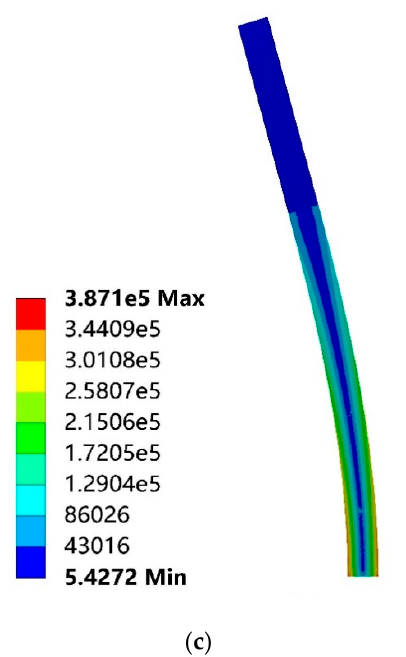
Figure 14. Stress (Pa) of T-shaped flexible beam at t = 10 s ( a ) Re = 25,500, ( b ) Re = 42,500, and ( c ) Re = 59,500.